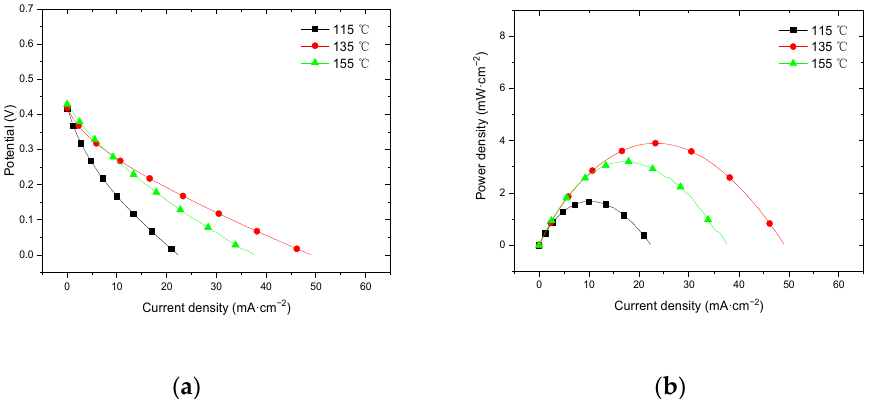
Figure 13. The effect of hot-pressing temperature on the performance of titanium mesh-based MEA at room temperature with air self-breathing environment. ( a ) Curve between current density and voltage; ( b ) curve between current density and power density.